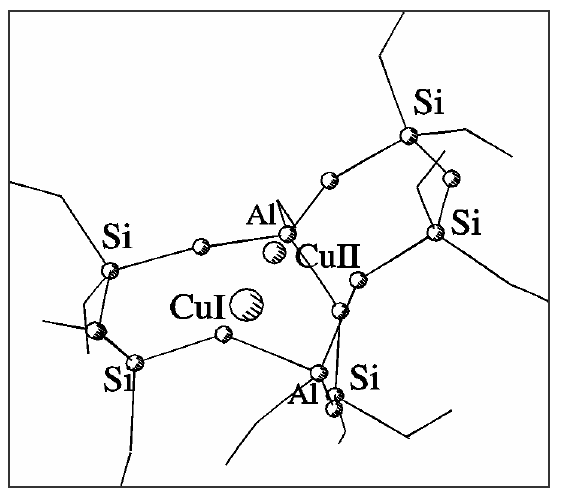
Figure 2. Geometry of NO adsorption on Cu 2+ and Cu + sites in a common 7T basket model of CuZSM-5